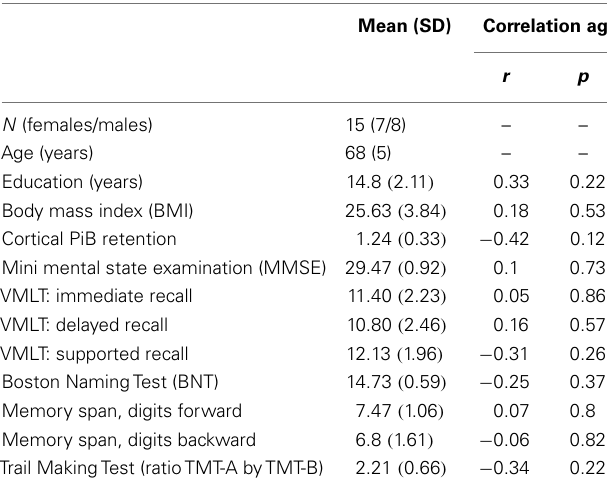
Table 1 | Demographics of the studied sample including neuropsychological test results .